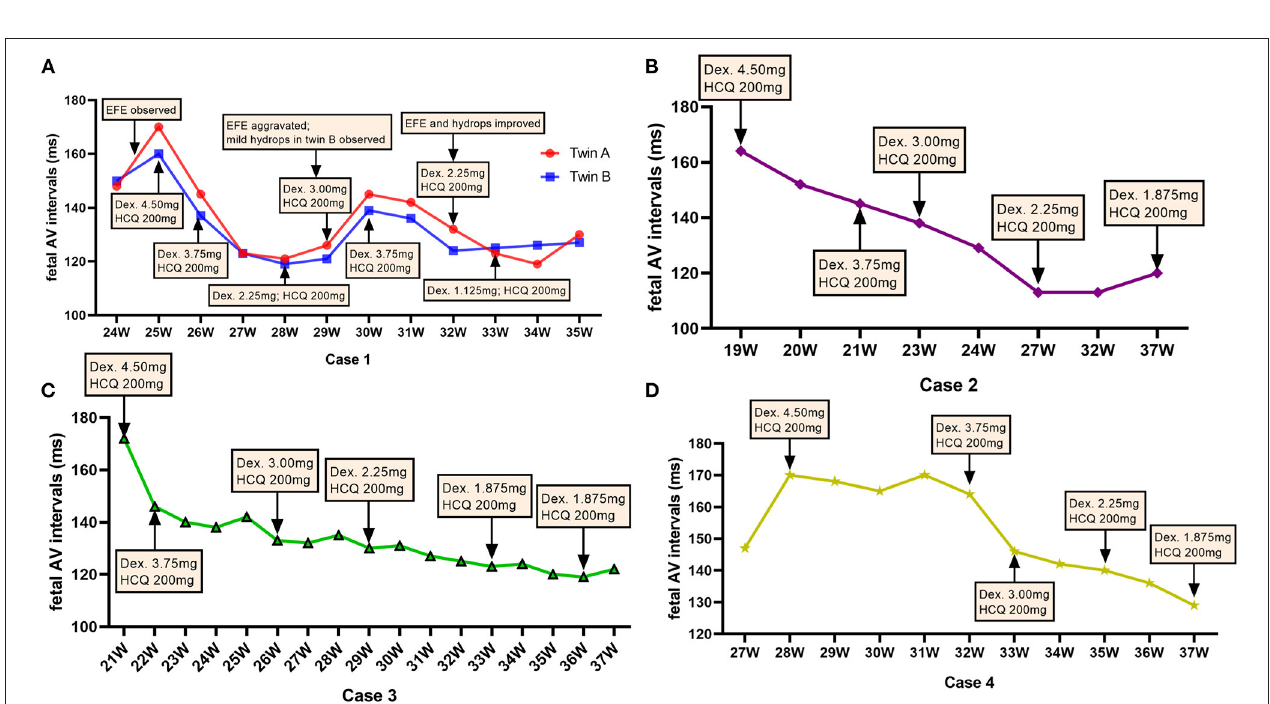
FIGURE 2 | Dexamethasone dose adjustments and fetal atrioventricular intervals. The dose of dexamethasone (Dex) was adjusted according to the change in the fetal atrioventricular (AV) intervals at different gestational weeks (GWs) throughout the pregnancy. (A) Represents the fetuses of case 1; (B) represents the fetus of case 2; (C) shows the fetuses of case 3; (D) shows the fetus of case 4. mg,